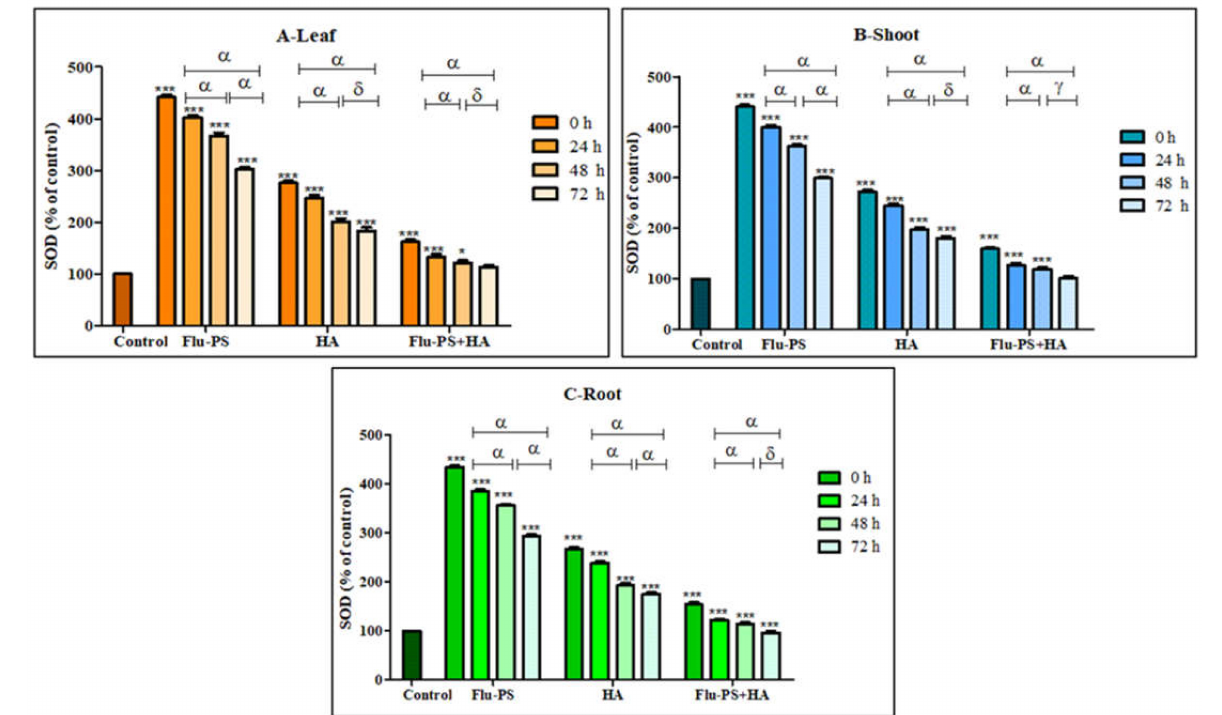
Figure 12. Percentage of superoxide dismutase (SOD) values of Flu − PS-, HA- and Flu − PS+HA- treated (( A ). Leaf, ( B ). Shoot, ( C ). Root) Solanum lycopersicum samples. Note: ‘ * *** ’ indicates the percentage difference with respect to the control; ‘ α , δ , γ ’ indicates a significant difference ( α = p < 0.001, δ = p > 0.05, γ = p < 0.05).